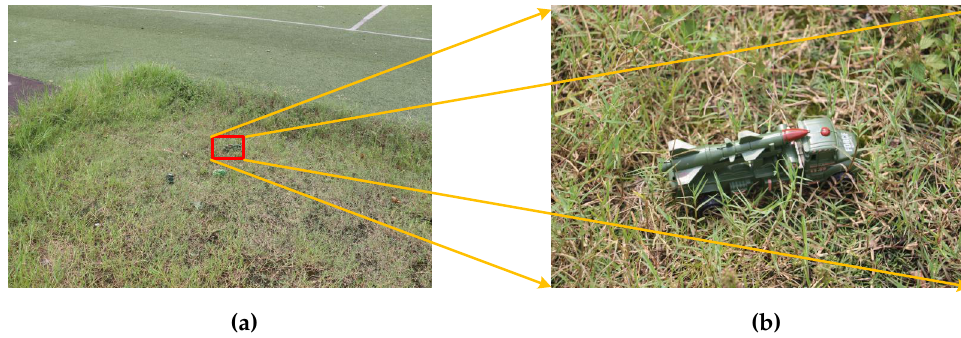
(a) (b) Figure 12. Images captured by the optical imaging system. ( a ) Imaging from the peripheral region. ( b ) Imaging from the central region. ( b ) Imaging from the central region.